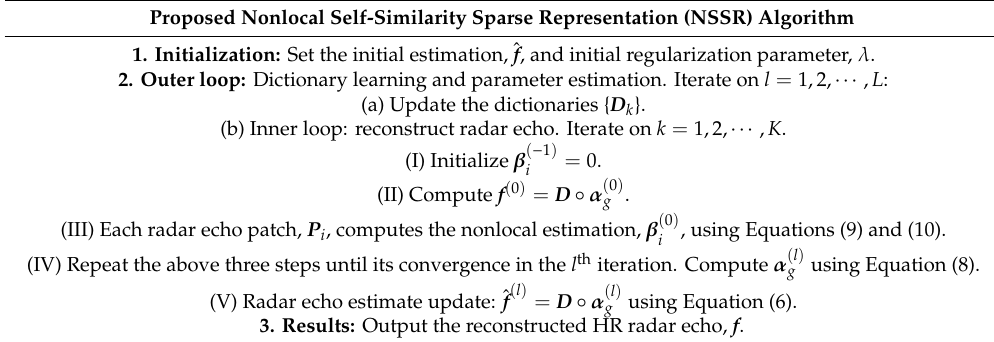
Table 1. The flow of the nonlocal self-similarity sparse representation (NSSR) algorithm. Proposed Nonlocal Self-Similarity Sparse Representation (NSSR) Algorithm